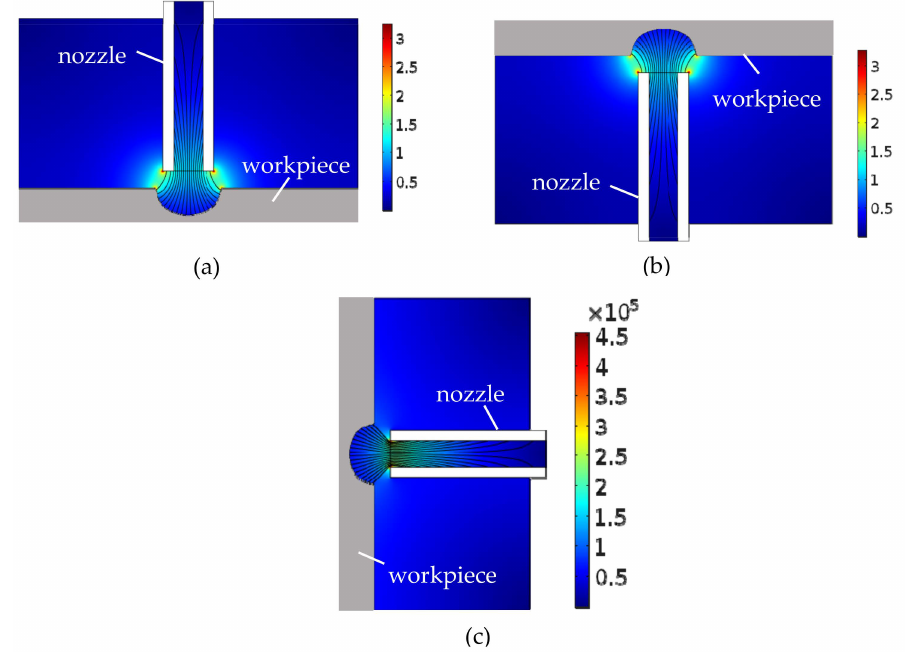
Figure 4. Simulated results of the current density distribution during Jet-ECM in the deep-dimple phase. ( a ) Vertically downstream orientation; ( b ) vertically upstream orientation; ( c ) horizontal